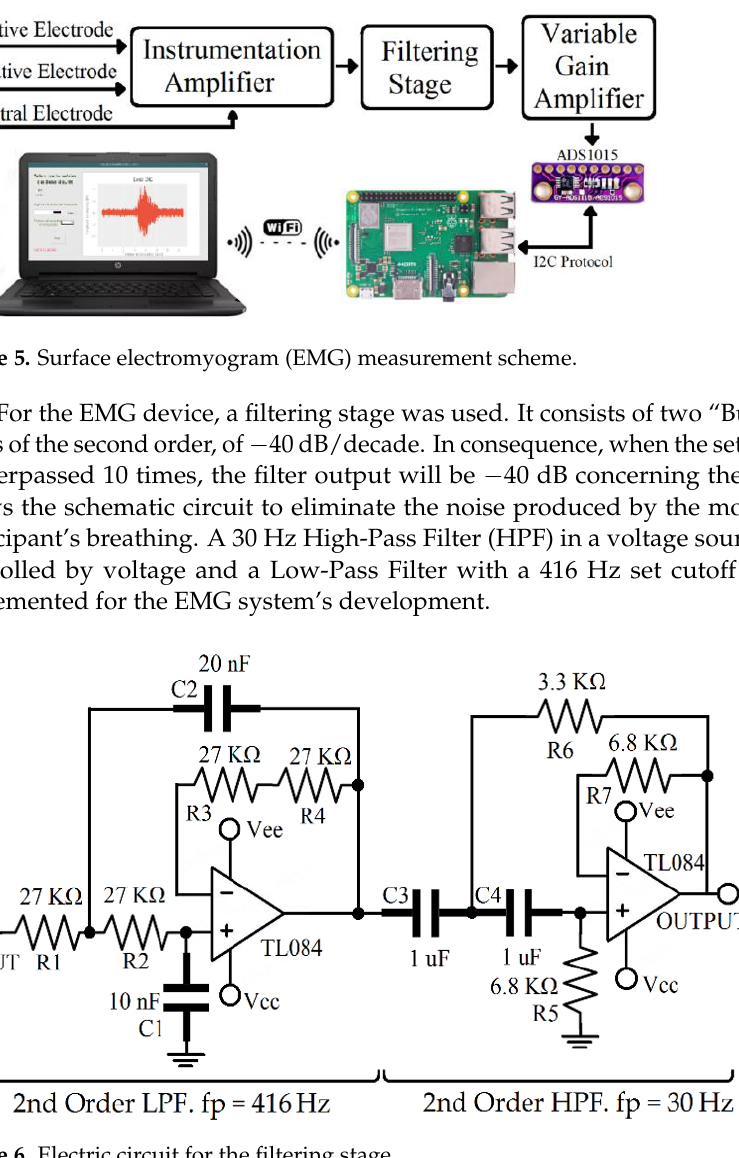
Figure 6. Electric circuit for the filtering stage.